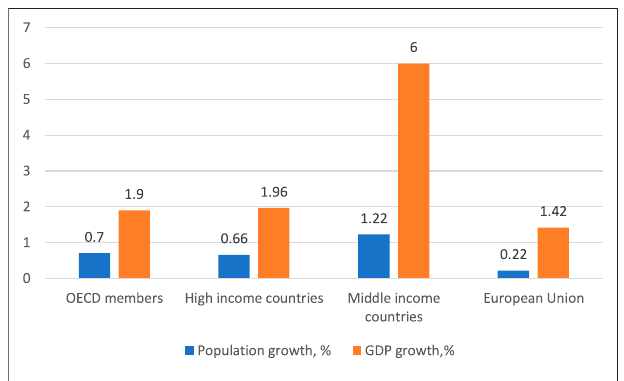
FIGURE 2 | GDP growth and population growth in selected regions, 2000 – 2015. Source: World